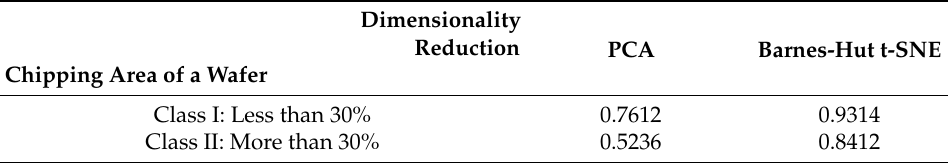
Figure 22. Training a DD-BLSTM model of index prediction. Table 3. Accuracy of chipping prediction using different dimensionality reductions.